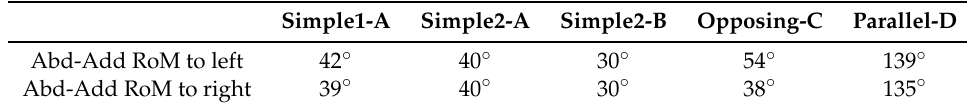
Table 2. Maximum actuator tip angles for abduction-adduction trajectory measurements.